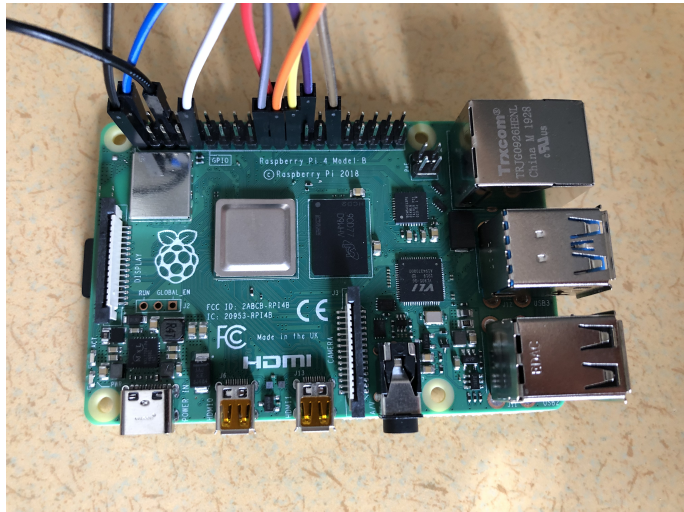
Figure 2. Computing unit—Raspberry Pi4 Model B.